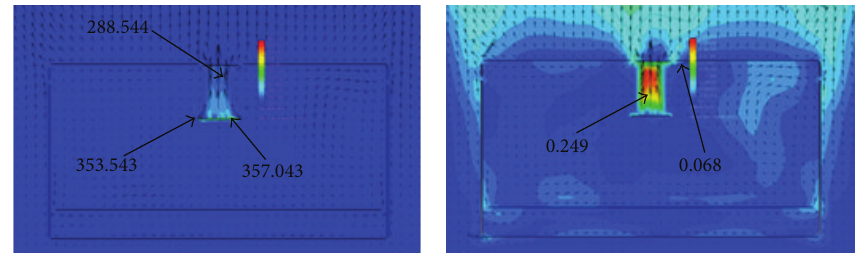
Figure 7: Longitudinal section temperature and velocity field of the test